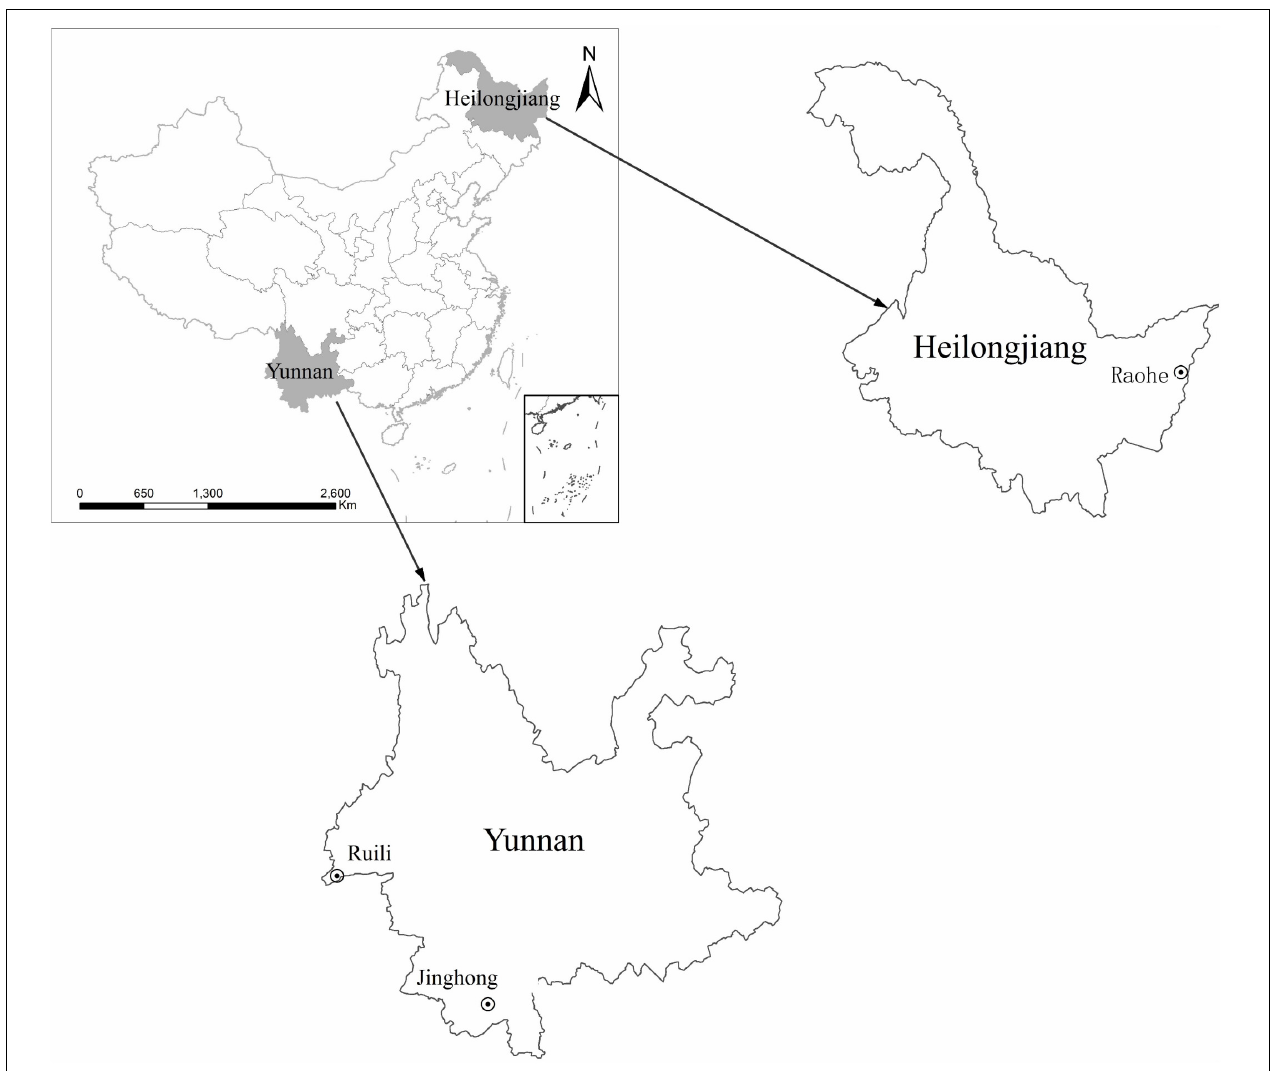
FIGURE 1 | Rodent trapping sites in Northeast and Southwest China.